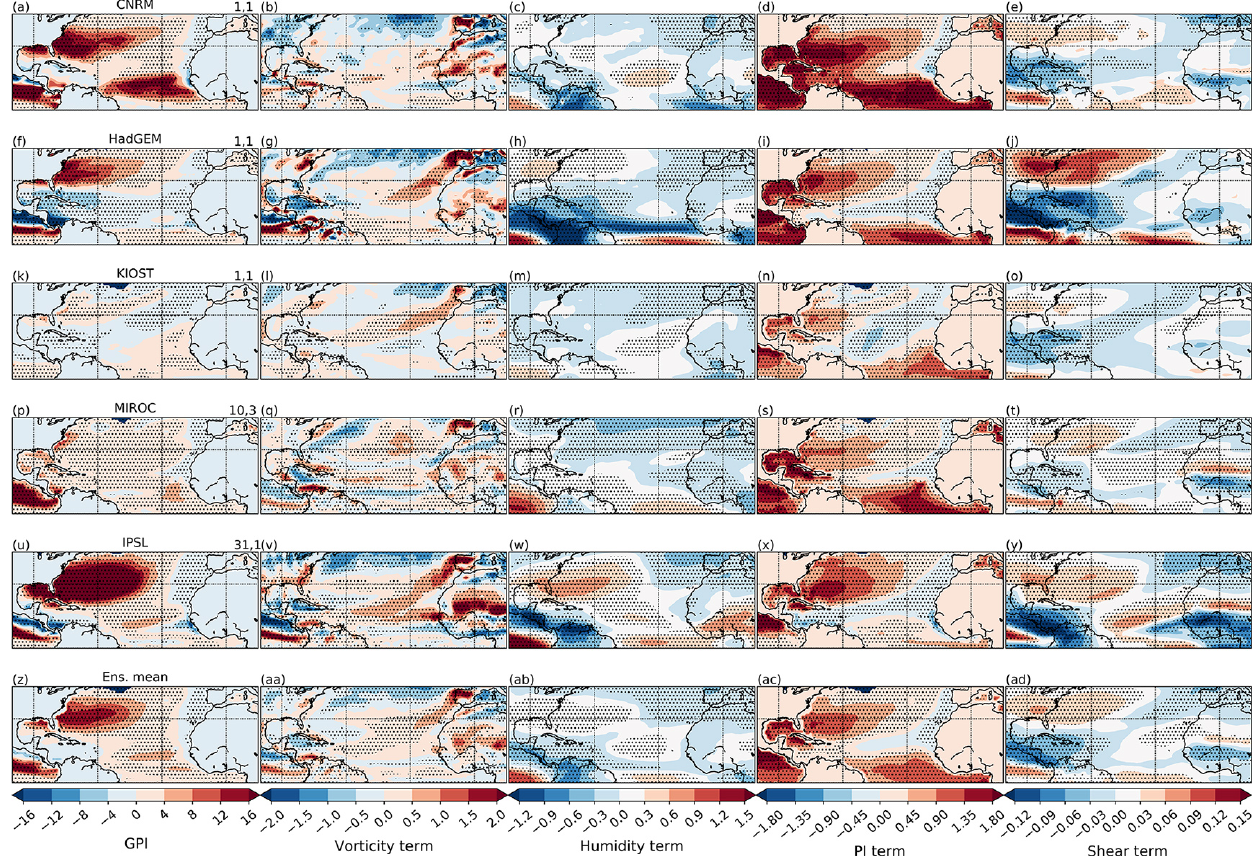
Figure 6. Projected change (future minus historical) in the GPI (first column) and the individual terms of the GPI equations (columns 2–5) for CNRM (top row), HadGEM (second row), KIOST (third row) MIROC (fourth row), and IPSL (fifth row) and ensemble mean (sixth row): vorticity term (second column), humidity term (third column), PI term (fourth column), and shear term (fifth column). Note that the vertical wind shear term is a function of the reciprocal of the wind shear, and so a positive difference indicates less vertical wind shear in the future. The number of ensemble members used for the historical and future periods are shown in the upper right of the first column (historical, future). Stippling represents statistical significance at the 95% level using Welch’s t